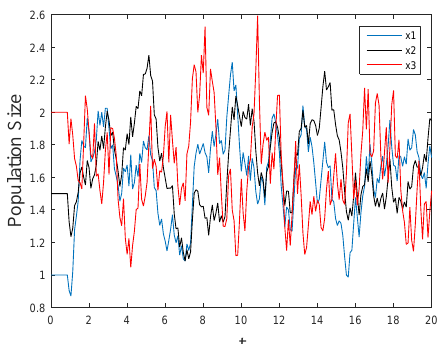
Figure 2 illustrate this.